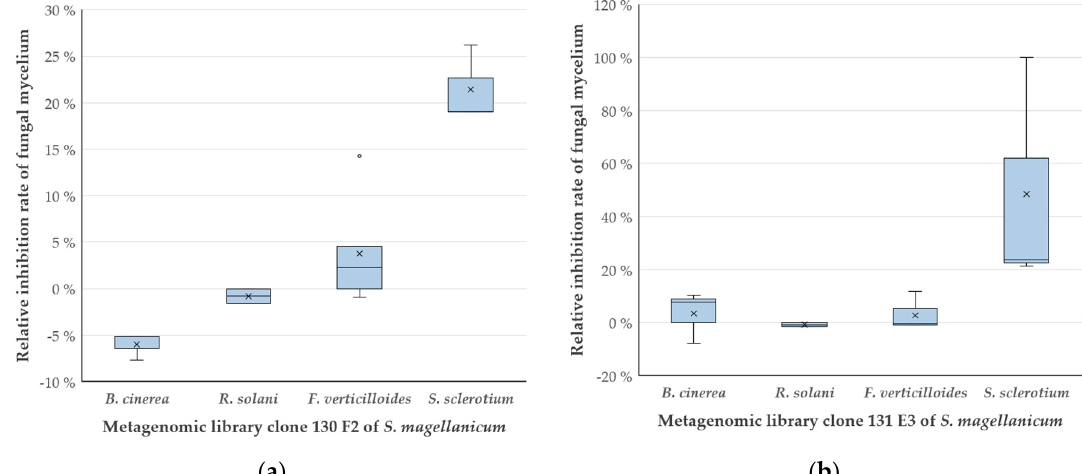
Figure 4. Effect of antagonistic fosmid clones from a moss metagenomic library on phytopathogenic fungi. Relative inhibition rates (in percent) of clone 130 F2 ( a ) and 131 E3 ( b ) as compared to the empty vector control strain E. coli EPI300 pCC2FOS against fungal mycelium from Rhizoctonia solani, Botrytis cinerea, Fusarium verticilloides and Sclerotinia sclerotium . The box plots show the median (-), the mean (×), the outliers (°) and the standard deviation (whiskers) based on PDVA tests with samples; sample size n = 3.